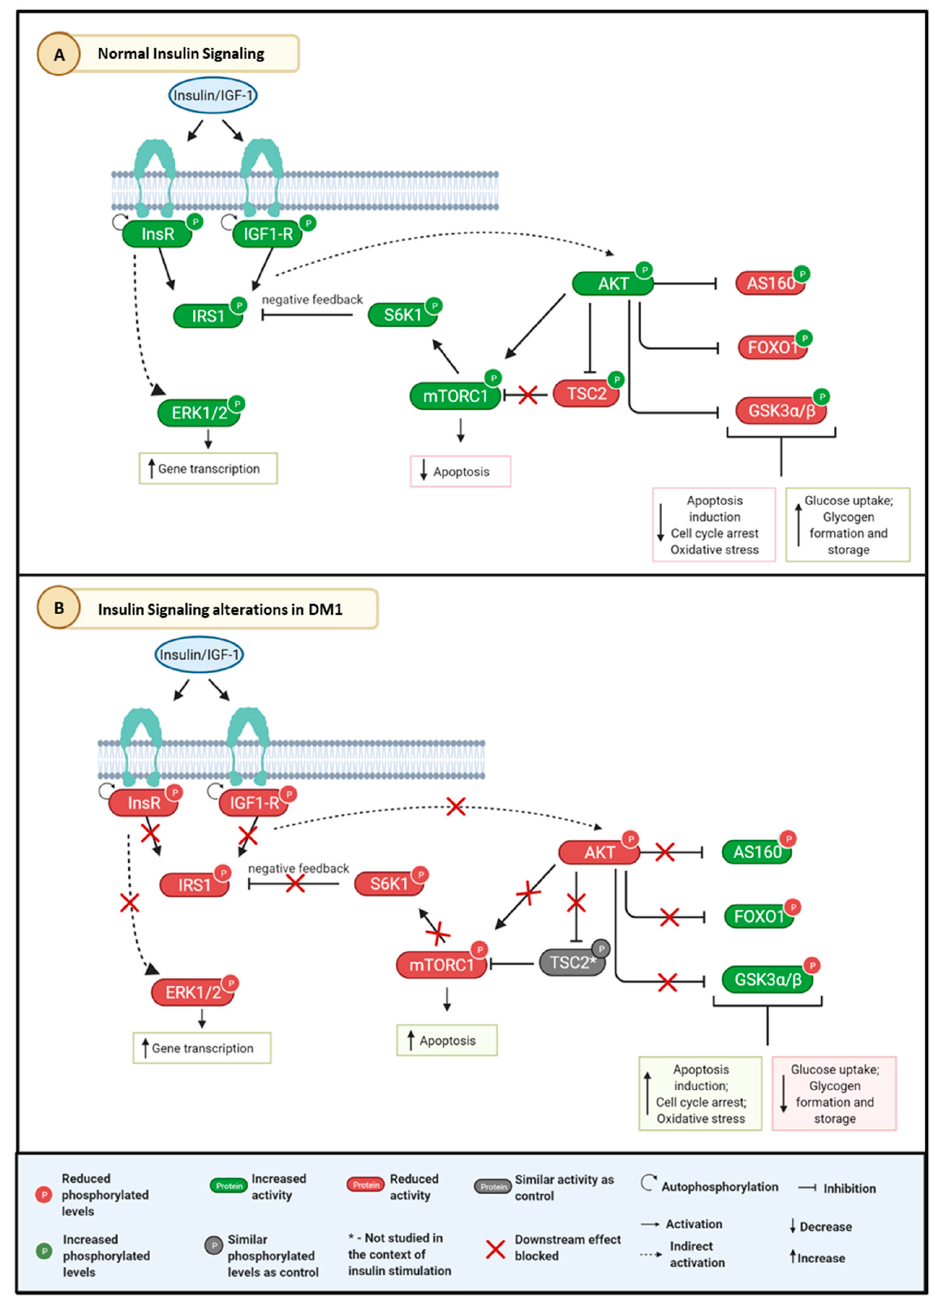
Figure 4. Schematic representation of the proposed mechanism of insulin signaling dysfunction in DM1. ( A ) Normal insulin signaling pathway; ( B ) Insulin signaling alterations in DM1 according to the results. The AKT/mTOR and MEK/ERK pathway have decreased levels of phosphorylation apoptosis. Created using Biorender.com. Abbreviations: AKT—Protein kinase B;